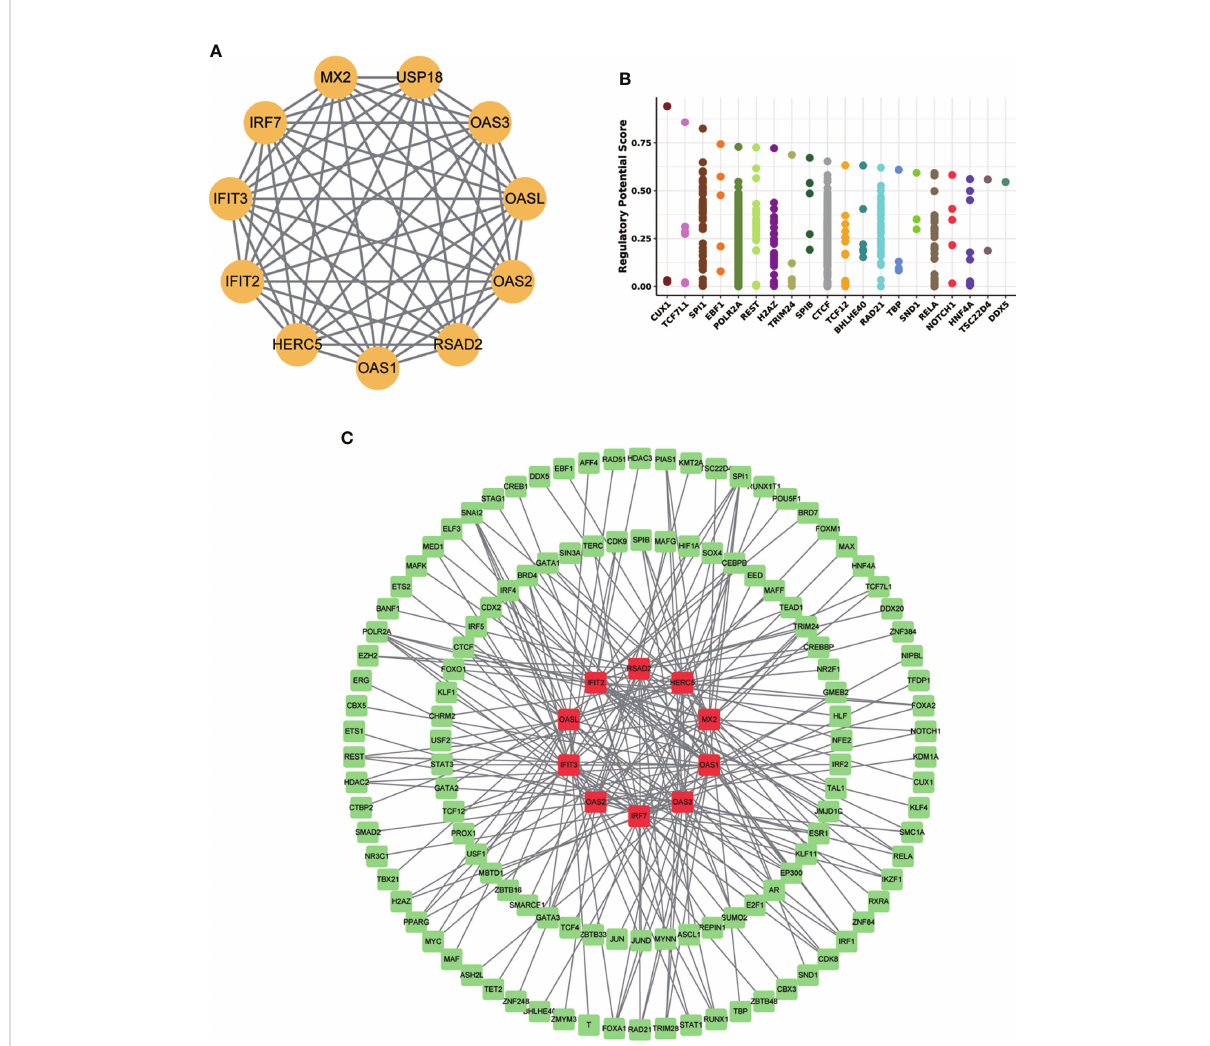
FIGURE 10 MX2 regulatory mechanism network. (A) The MX2 PPI network constructed by the STRING database. (B) The top 20 transcription factors regulating MX2 in the Cistrome DB database. (C) Protein-interacting gene-transcription factor (TF) network. Red represents genes and green represents TFs.